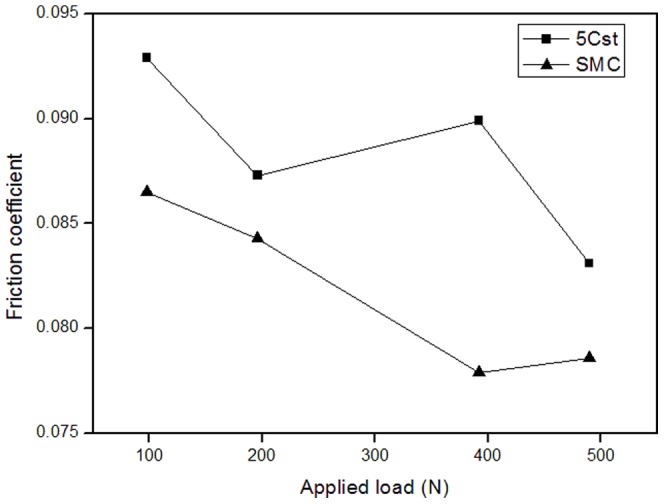
Effect of load on friction coefficient.